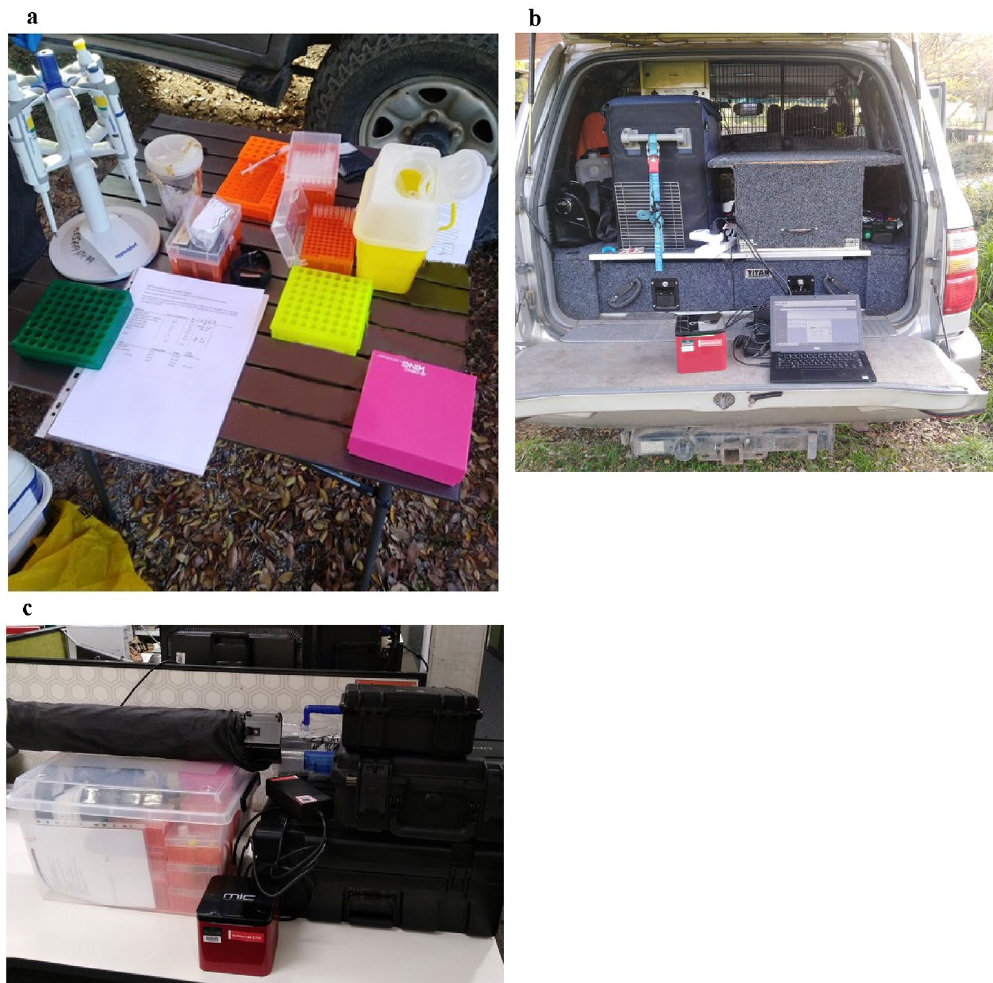
Figure 2. Deployed and functional portable laboratory set up. ( a ) Mid-RNA extraction in-field using the Biomeme M1 RNA extraction kit. ( b ) The MIC PCR machine performing that TaqMan assay out the back of the Landcruiser. ( c ) The entire kit packed up (all equiptment listed in Supplamentary data